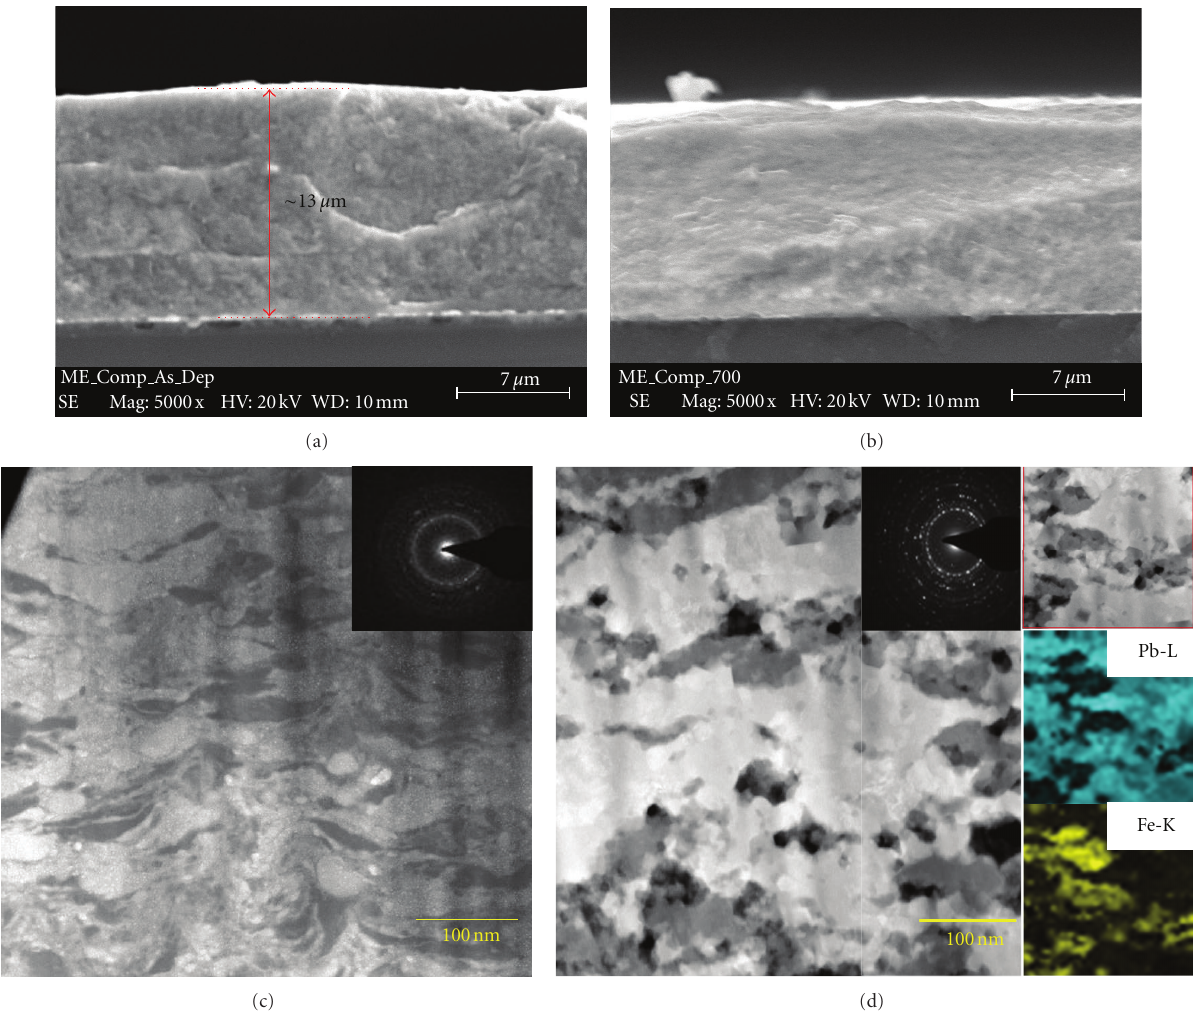
Figure 6: Microstructural analysis of 3-2 nanocomposite thick films by AD cross-sectional SEM image of (a) as-deposited and (b) annealed film. STEM micrographs and SAED of (c) as-deposited and (d) annealed film and EDX